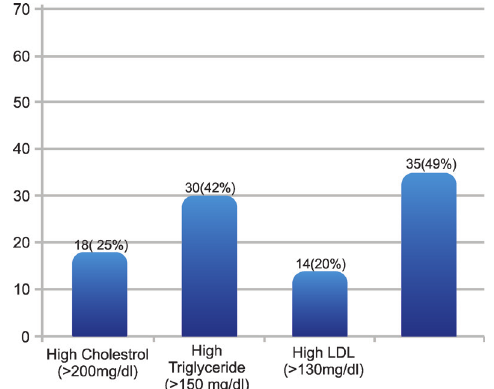
Figure 2. Comparison of the lipid profile in the active group and the inactive